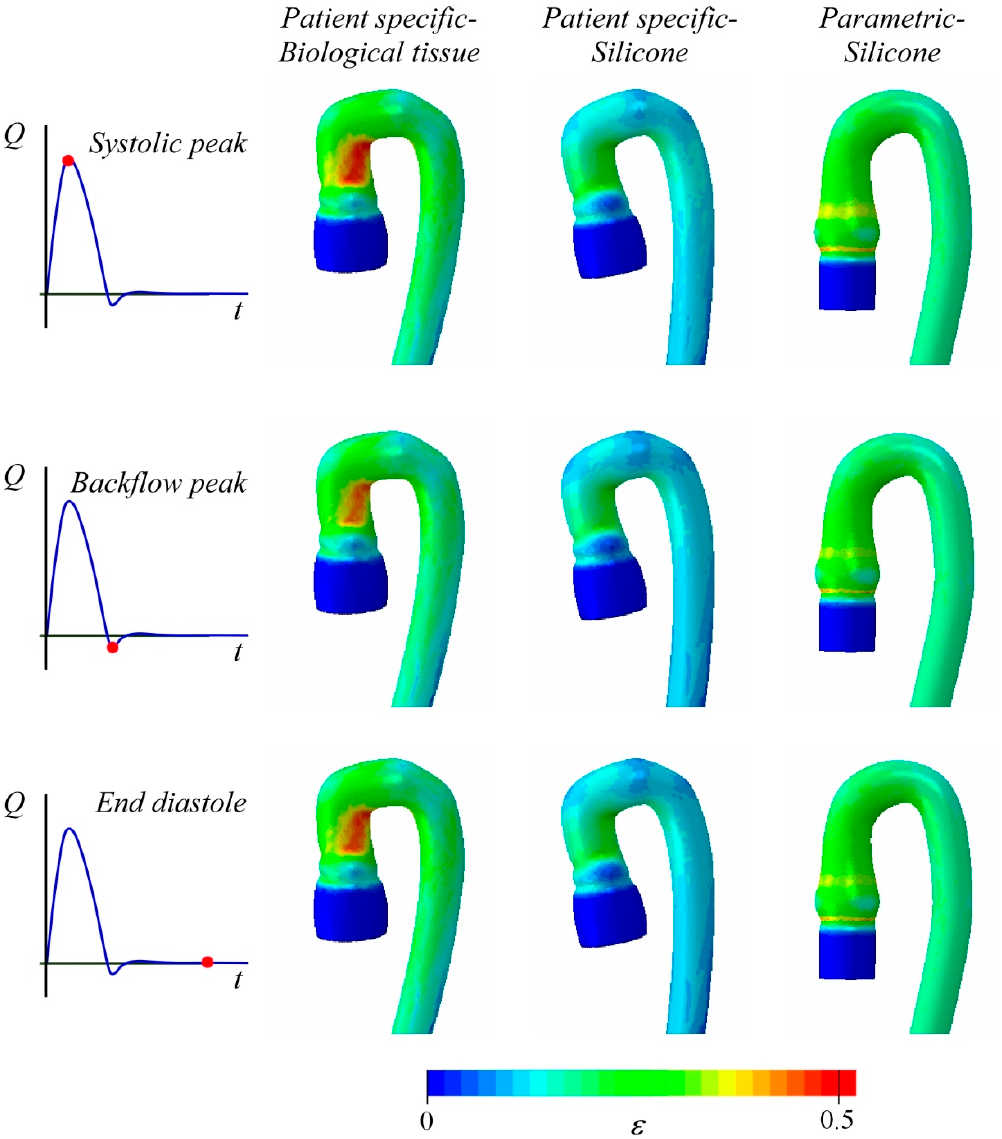
Figure 6. Maximum principal strain computed for the PSB model (column on the left), the PSS model (column at center), and PMS model (column on the right) at three time instants: the systolic peak (first row), the backflow peak (second row), and at the end diastole (third row).